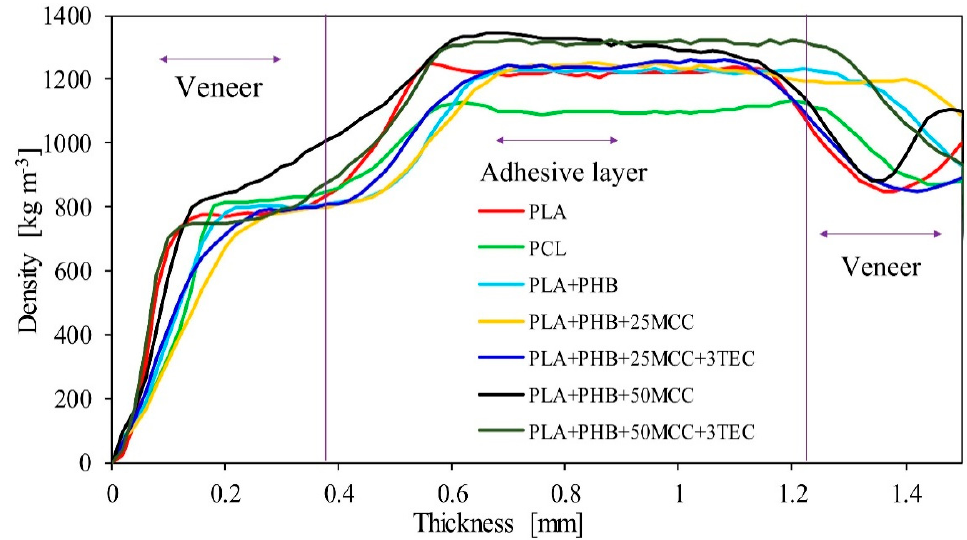
Figure 4. Density profiles of the produced five-layer composites.